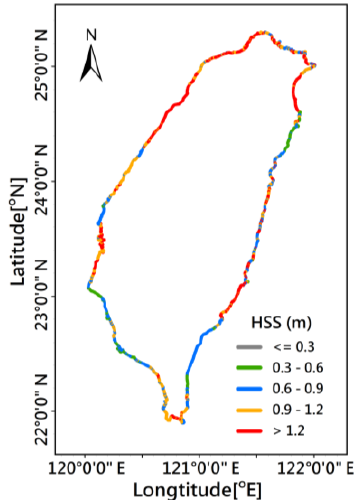
Figure 8. The highest storm surge (HSS) distributions for C1–C9. ( a ) category 1, ( b ) category 2, ( c ) category 3, ( d ) category 4, ( e ) category 5, ( f ) category 6, ( g ) category 7, ( h ) category 8 and ( i ) category 9.